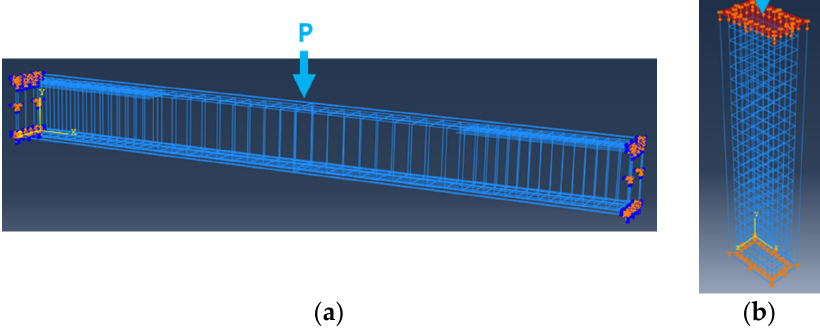
Figure 15. Boundary and loading conditions of girder model ( a ) and column model ( b ).